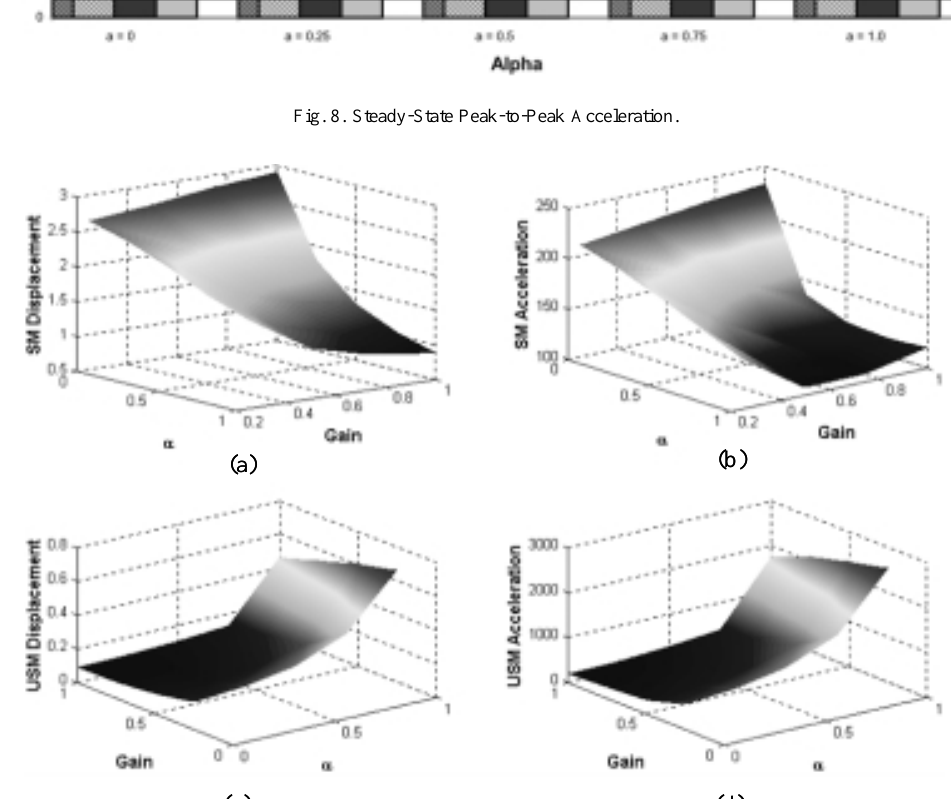
Fig. 9. Effects of α and Gain on Steady-State Response: (a) Sprung Mass Peak-to-Peak Displacement; (b) Sprung Mass Peak-to-Peak Acceleration; (c) Unsprung Mass Peak-to-Peak Displacement; (d) Unsprung Mass Peak-to-Peak Acceleration. fits observed for the sprung mass far exceed those ob- the peak-to-peak displacement of the unsprung mass is served for the unsprung mass. Even at pure ground- reduced below that of the passive system. hook, α = 0 , the unsprung mass does not show much Peak-to-peak accelerations of both the bodies offer improvement over the range of alphas. Nonetheless, another means of evaluating the transient